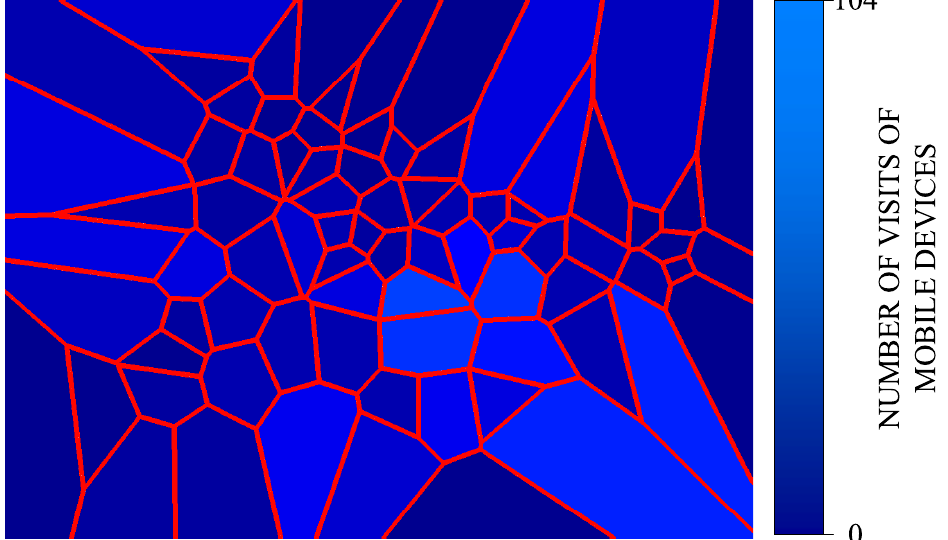
Figure 6. Cumulative persistence map related to a specific simulation. Brighter regions are those where mobile agents passed most often. Darker regions were visited